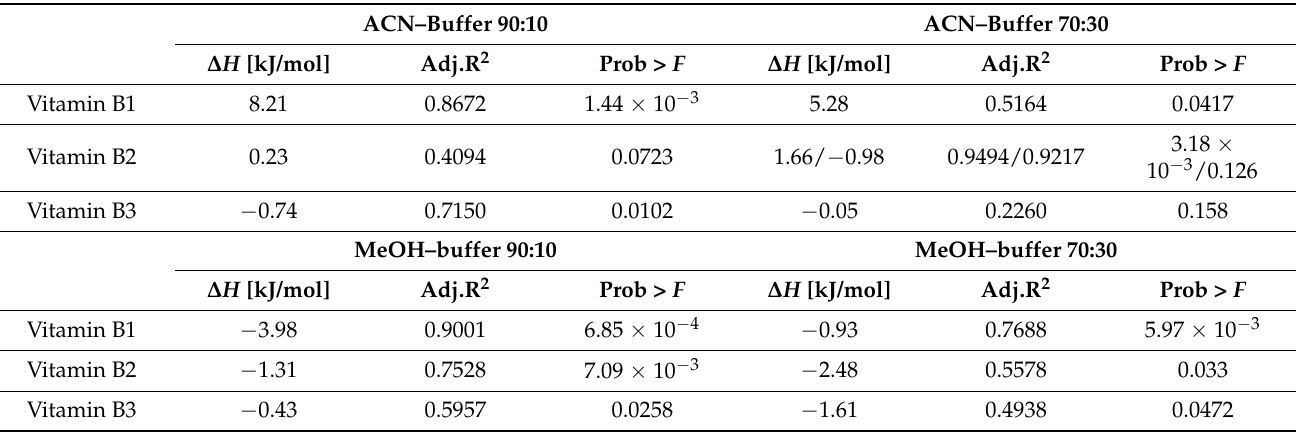
Table 4. Regression data of Van’t Hoff equation for analytes in column N for different mobile phase